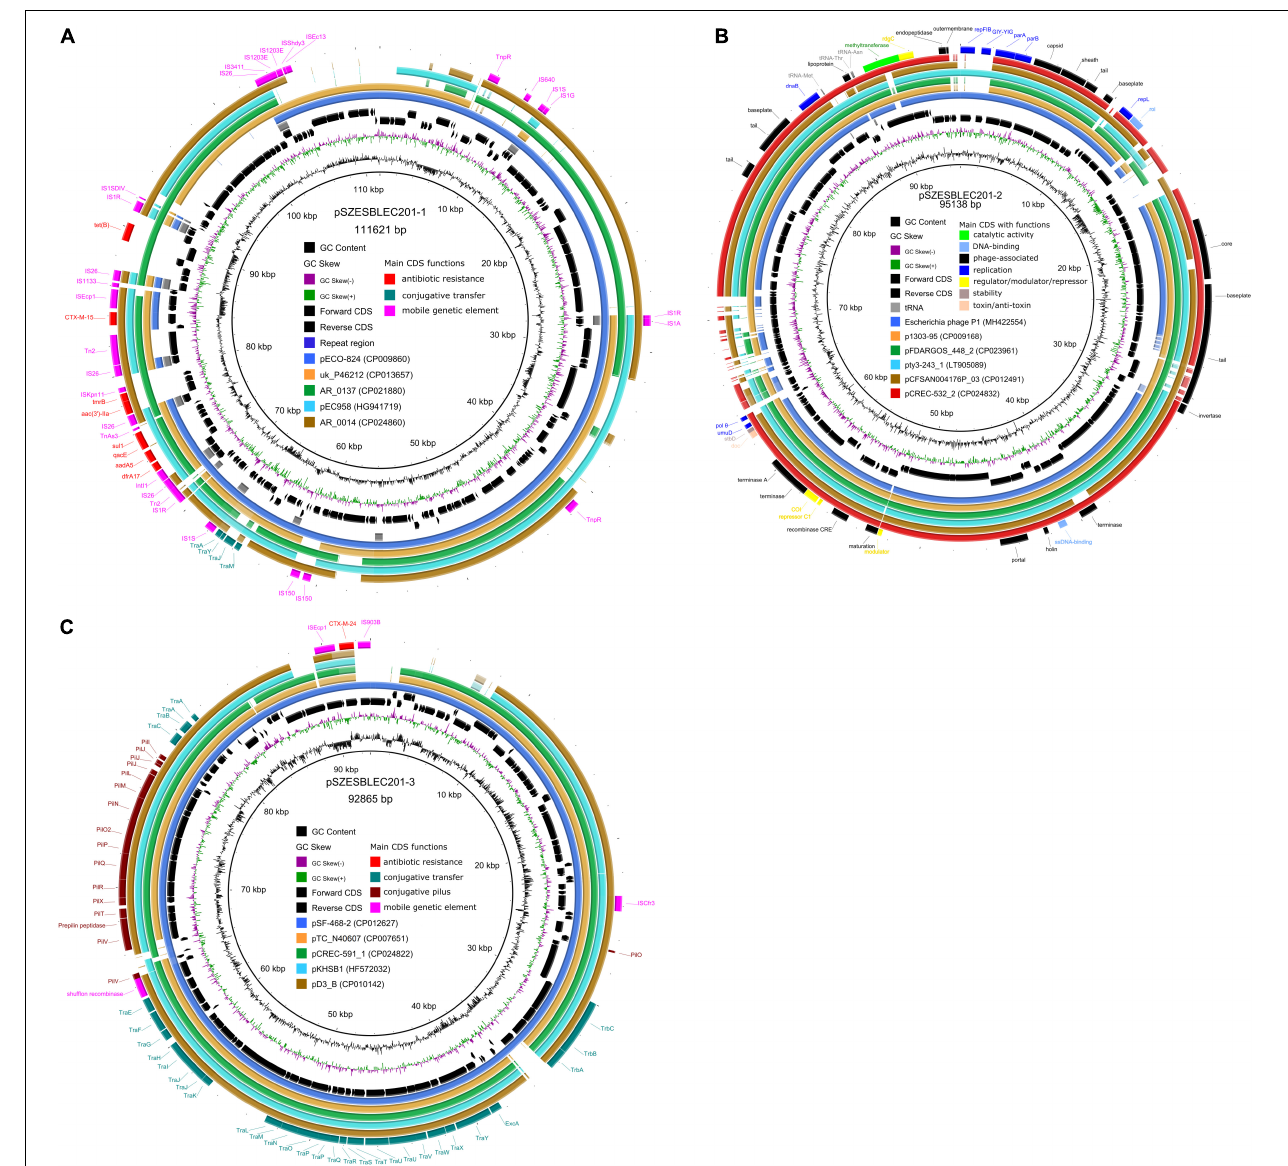
FIGURE 4 | Comparative schematic representation of pSZESBLEC201-1, pSZESBLEC201-2, and pSZESBLEC201-3 with their closest related plasmids. (A) Multiple genome comparison using BLAST ring image generator (BRIG) with pSZESBLEC201-1 as the reference. (B) Multiple genome comparison using BRIG with pSZESBLEC201-2 as the reference. (C) Multiple genome comparison using BRIG with pSZESBLEC201-3 as the